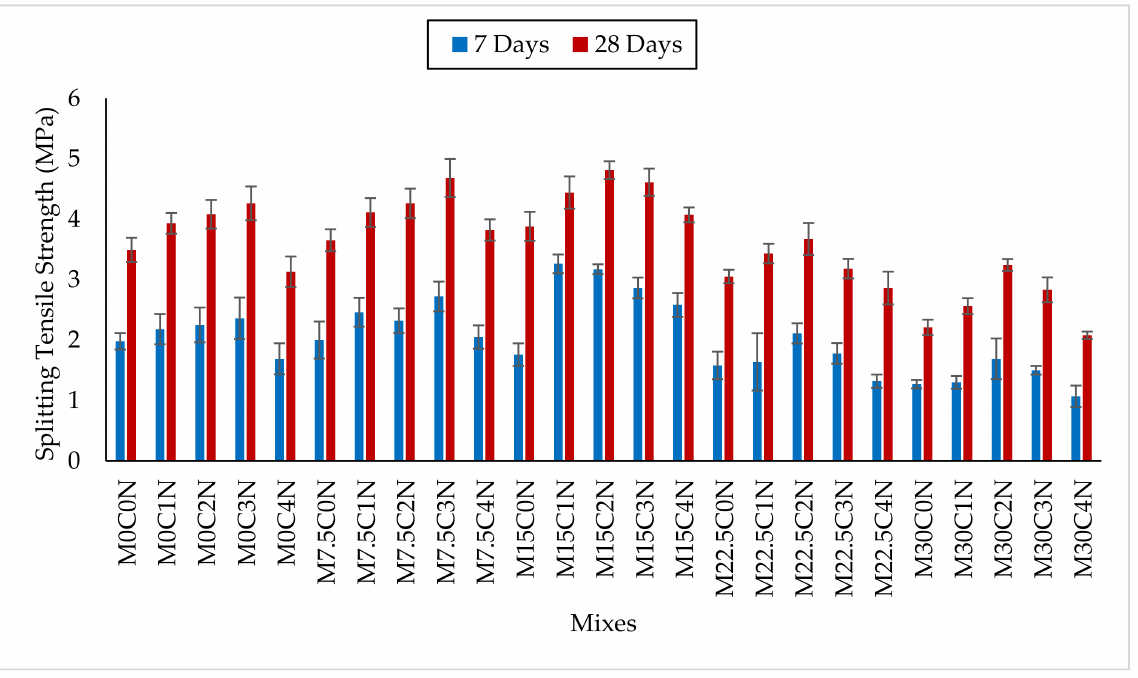
Figure 8. Splitting Tensile Strength